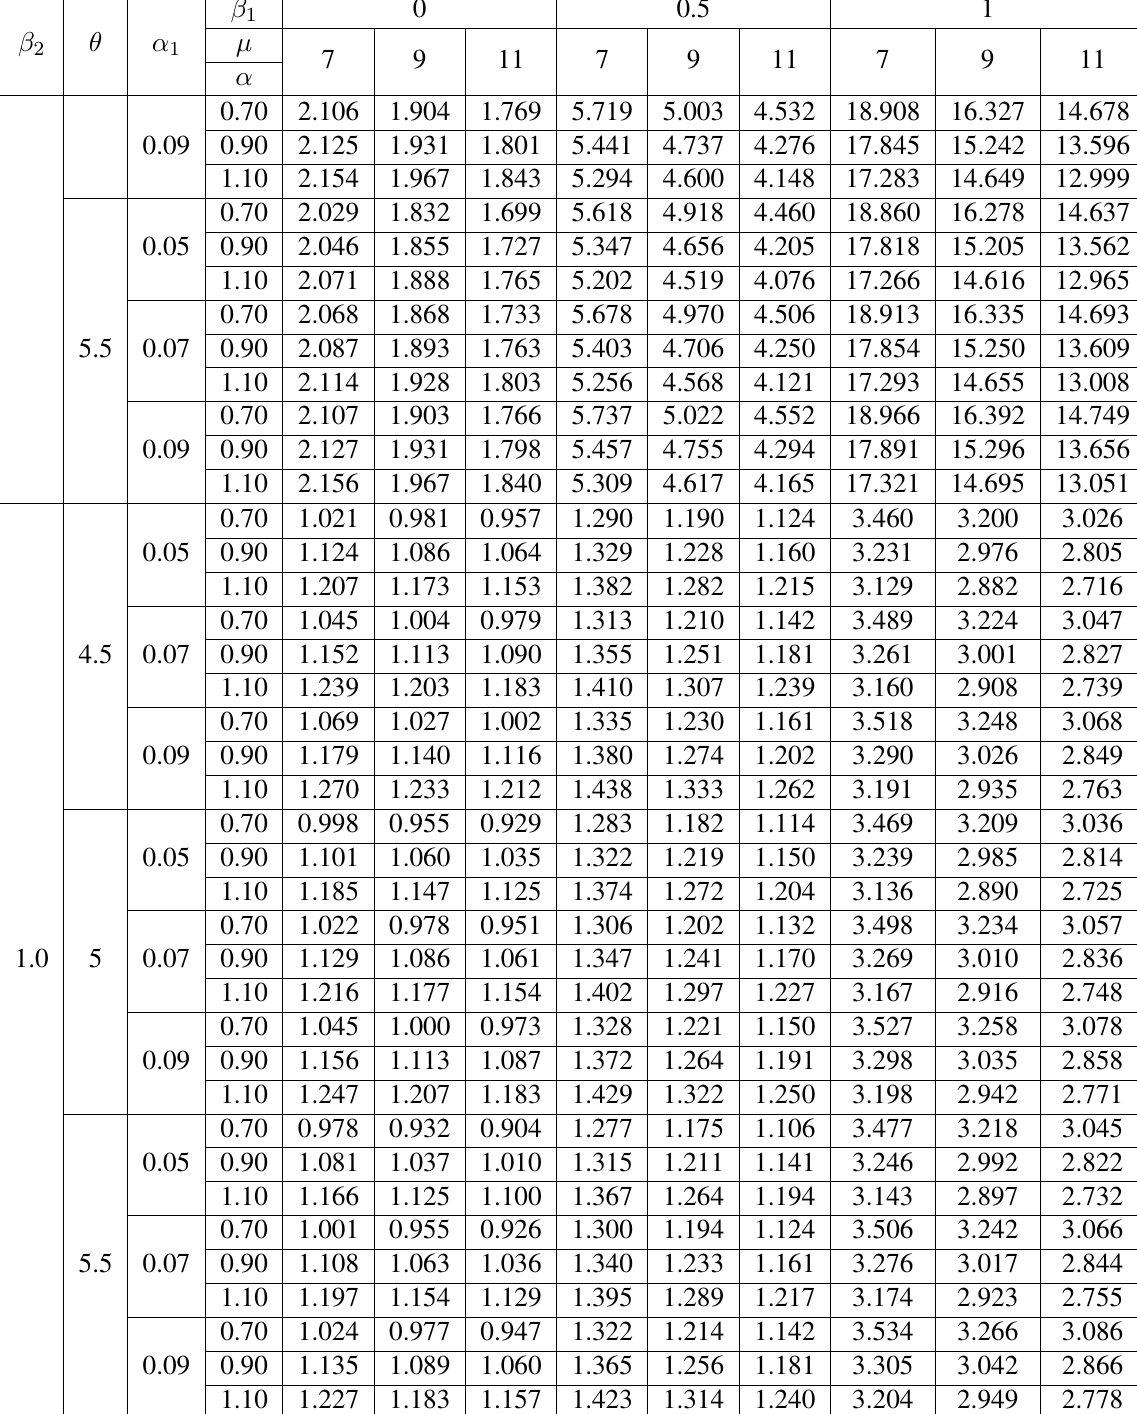
Table 4: The variation of TCV under the parameter variation β